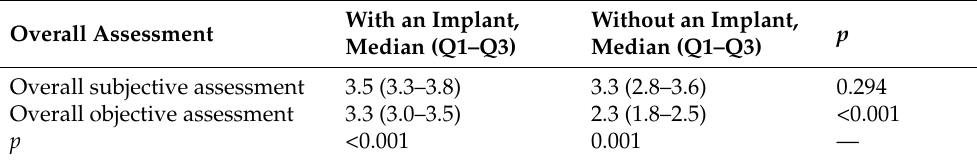
Table 7. Subjective and objective assessment of cosmetic outcome: overall scores in patients with and without an orbital implant.